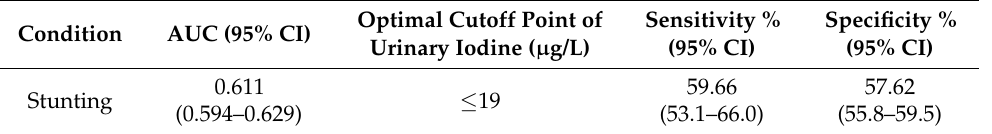
Table 3. Results of receiver operating characteristics (ROC) for urinary iodine in µ g/L to predict stunting among school children.